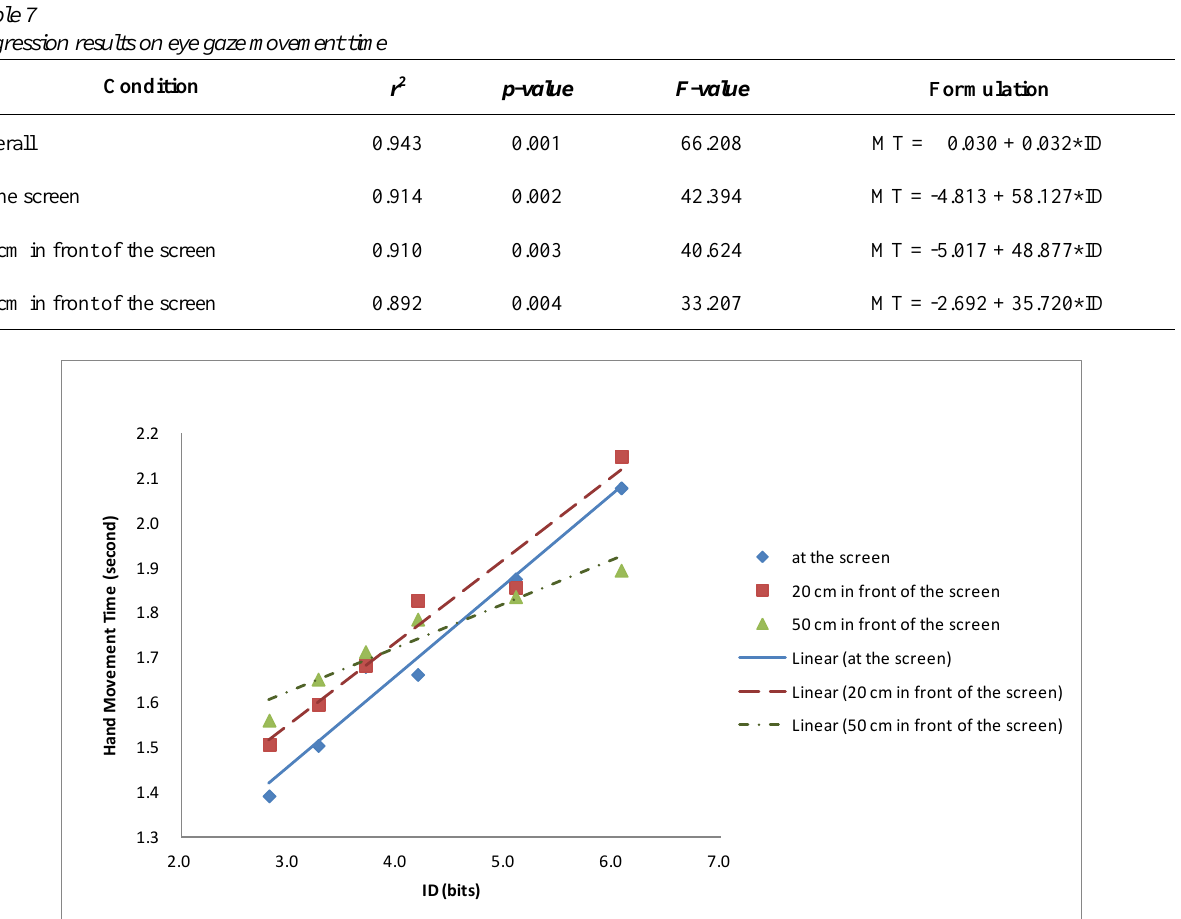
Linear (at the screen) Linear (20 cm in front of the screen) Linear (50 cm in front of the